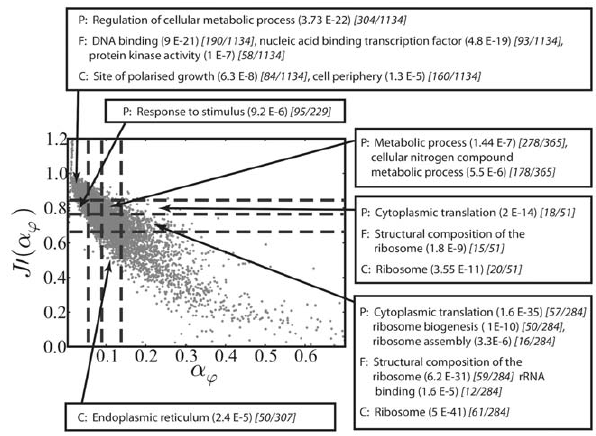
Figure 5. Scatter plot of the estimated initiation rates a Q versus the slope of the protein production rate J evaluated at a Q . Both distributions of initiation rates and slopes have been subdivided in quartiles (dashed lines), defining 16 regions. Boxed annotations indicate those GO categories that are overrepresented in each quartile sector (P; GO process, F; function, C; component) with the P-value indicated as a power 10 exponent (E). The enrichments in each region are indicated in the square brackets as xx/yy, where ‘xx’ is the number of genes with that specific annotation and ‘yy’ the total number of genes in the